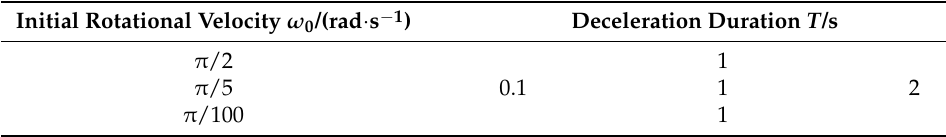
Table 5. Parameters of rigid body